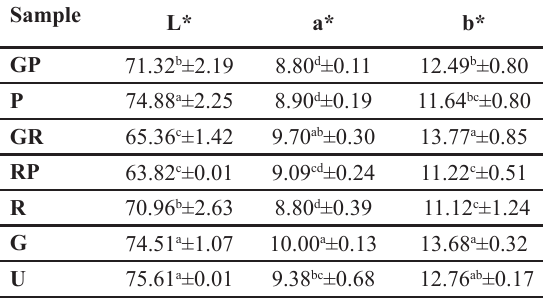
Table 4: Colour profile of yoghurt from pre-treated Bambara groundnut.